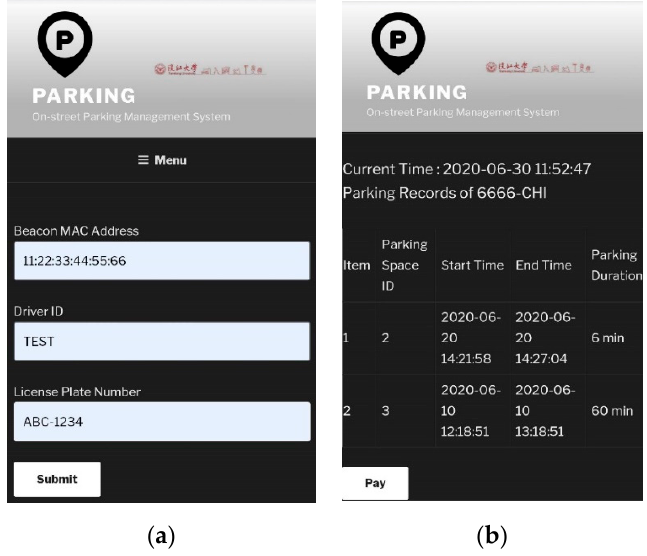
Figure 5. Web interfaces: ( a ) Vehicle Registration page for drivers to fill in registration data, ( b ) Parking Record and Payment page showing the parking records of a specific vehicle.